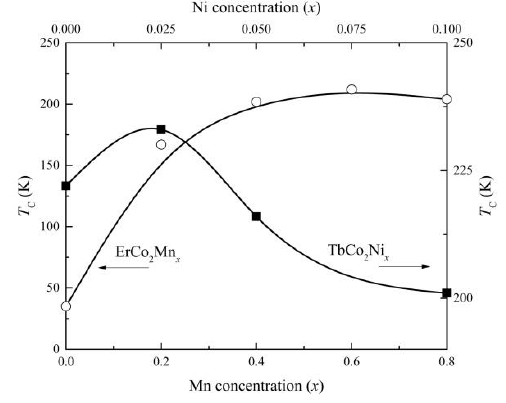
Fig. 3. Concentration dependences of the Curie temperature for ErCo 2 Mn x ( ○ ) and TbCo 2 Ni x ( ■ )